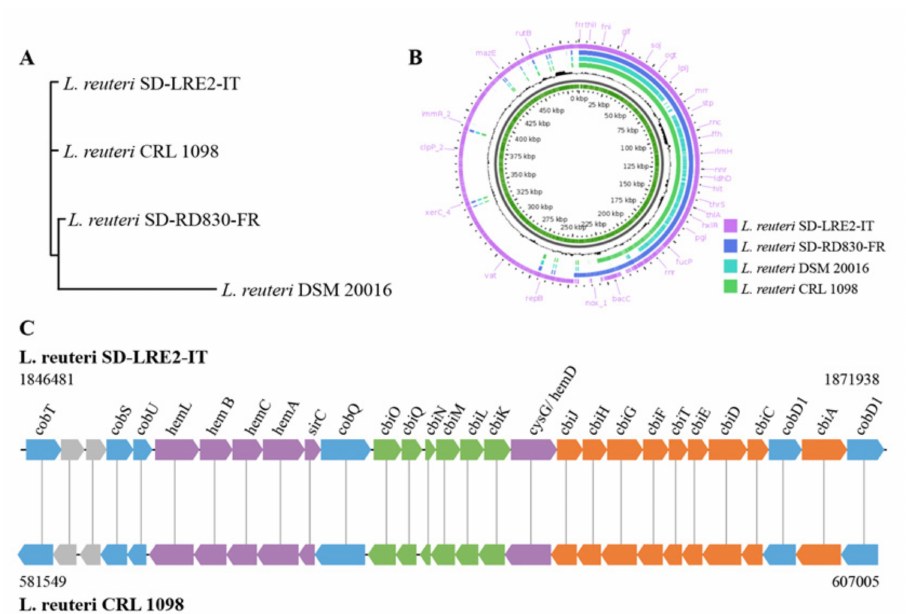
Figure 3. Genomic comparison of L. reuteri strains. ( A ) Phylogenetic trees based on the whole genome of all L. reuteri strains. ( B ) Pangenome analysis of four L. reuteri strains. The inner-most green slot shows the constructed pangenome using all four L. reuteri strains. The pangenome is constructed by appending unique regions onto the initial seed genome (in this case L. reuteri CRL 1098). The inner black slot represents the % GC content of the genomes. The other four outer slots display the BLAST hits of each strain. Empty regions on the query slots indicate areas where there were no BLAST hits between the reference L. reuteri CRL 1098 and the three query files ( L. reuteri strains DSM 20016, SD-LRE2-IT and SD-RD830-FR respectively. ( C ) Schematic representation of the coenzyme B12 biosynthesis gene cluster of L. reuteri SD-LRE2-IT and comparison of gene order with the L. reuteri CRL 1098 strain [18]. The numbers 1846481 to 1871938 represent the B12 biosynthesis gene cluster of L. reuteri strain SD-LRE2-IT and 581549 to 607005 represent L. reuteri strain CRL 1098. The color code represents genes that are involved in the synthesis of: uroporphyrinogen III (purple); the lower ligand (blue); adenosylcobinamide (orange); cobalt transport (green); and not related to B12 biosynthesis when depicted in grey. Functional annotation: cobD , threonine-phosphate decarboxylase (EC 4.1.1.81); cobS , adenosylcobinamide-GDP ribazoletransferase (EC 2.7.8.26); cobT , n icotinate-nucleotidedimethylbenzimidazole phosphoribosyltransferase (EC 2.4.2.21); cobU , adenosylcobinamide kinase (EC 2.7.1.156)/adenosylcobinamide-phosphate guanylyltransferase (EC 2.7.7.62); hemL , glutamate-1-semialdehyde 2,1-aminomutase (EC 5.4.3.8); hemB , d-aminolaevulinic acid dehydratase (EC 4.2.1.24; hemC, porphobilinogen deaminase (EC 2.5.1.61); hemA , glutamyl- tRNA reductase (EC 1.2.1.–); sirC , glutamyl-tRNA reductase (EC 1.2.1.–); cobQ , cobyric acid synthase; cbiO , cobalt transport ATP-binding protein; cbiP, adenosylcobyric acid synthase (EC 6.3.5.10); cbiQ , cobalt transport protein; cbiN , cobalt transport protein; cbiM , cobalt transport protein; cbiL , precorrin-2 C20-methyltransferase (EC 2.1.1.130); cbiK , sirohydrochlorin cobaltochelatase (EC 4.99.1.3); cysG / hemD , uroporphyrin-III C-methyltransferase (EC 2.1.1.107)/uroporphyrinogen-III synthase (EC 4.2.1.75); cbiJ , precorrin-6X reductase (EC 1.3.1.54); cbiH , precorrin-3B C17- methyltransferase (EC 2.1.1.131); cbiF , precorrin-4 C11-methyltransferase (EC 2.1.1.133); cbiG , precorrin-5A C20-acyltransferase (EC 2.3.1.–); cbiC , precorrin-8X methylmutase (EC 5.4.1.2); cbiD , precorrin-5B C1-methyltransferase (EC 2.1.1.–); cbiE , precorrin-6Y C5,15-methyltransferase [decarboxylating] subunit CbiE (EC 2.1.1.132); cbiT , precorrin- 6Y C5,15-methyltransferase [decarboxylating] subunit CbiT (EC 2.1.1.132); cobD1 , cobalamin biosyn- thesis protein; cbiA ; cobyrinic acid a,c-diamide synthase (EC 6.3.1.–); cobD2 , threonine-phosphate decarboxylase (EC